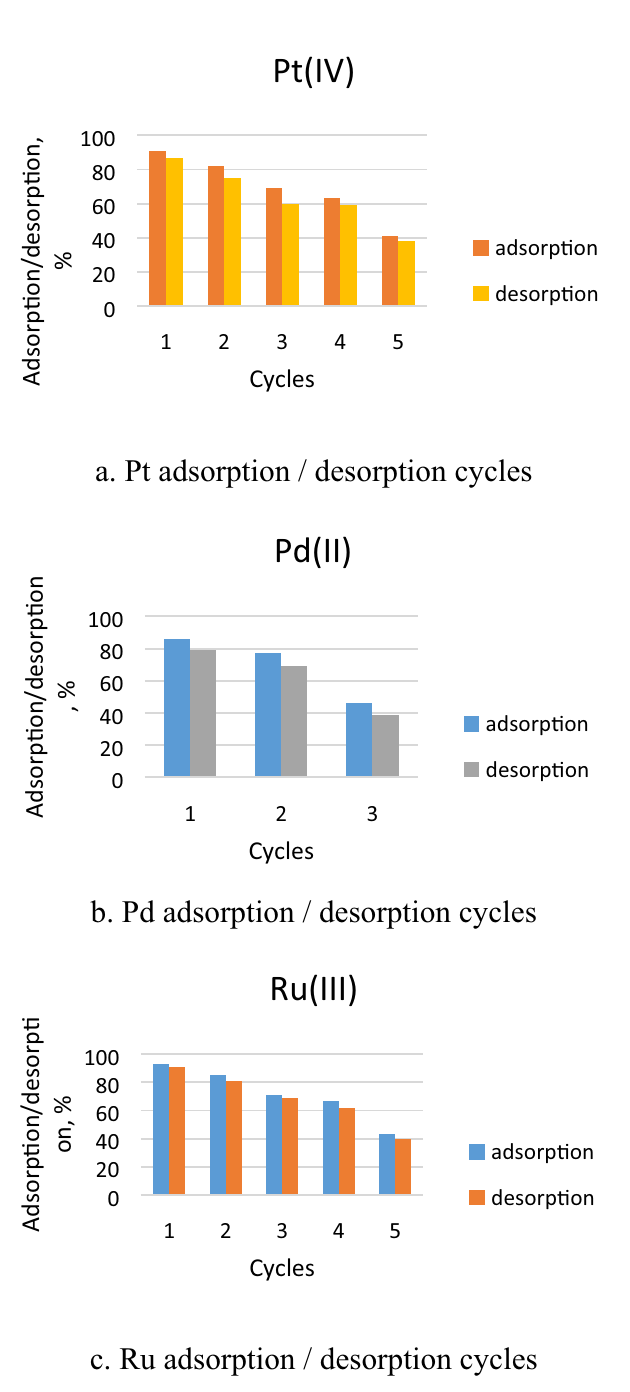
Figure 15. Adsorption/desorption cycles obtained for CH-DB18C6 adsorbent